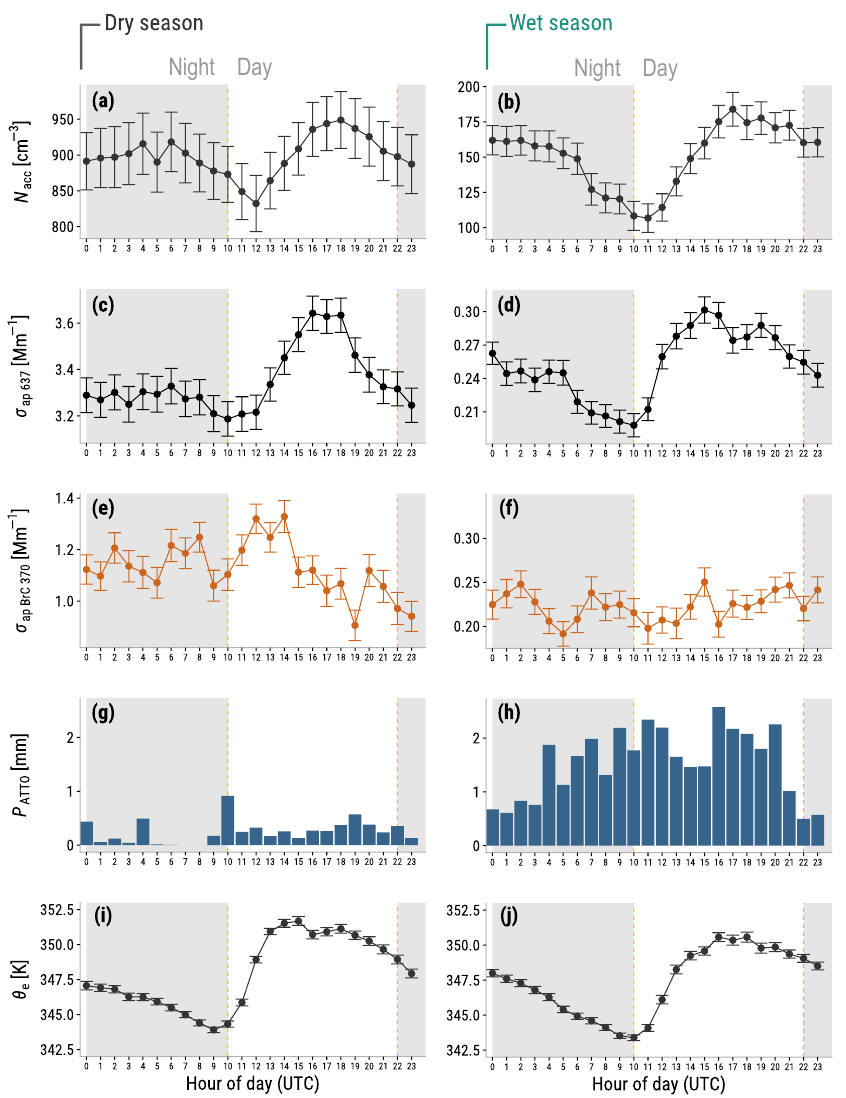
Figure 5. Diel variation of (a, b) median of the accumulation mode particle number concentration, N acc , (c, d) median of the absorption coefficient at 637nm, (e, f) median of the BrC absorption coefficient at 370nm, (g, h) precipitation rate, and (i, j) median of the equivalent potential temperature. Gray and white backgrounds correspond to the night and day times, respectively. Error bars correspond to the standard error. Please note the different y axis